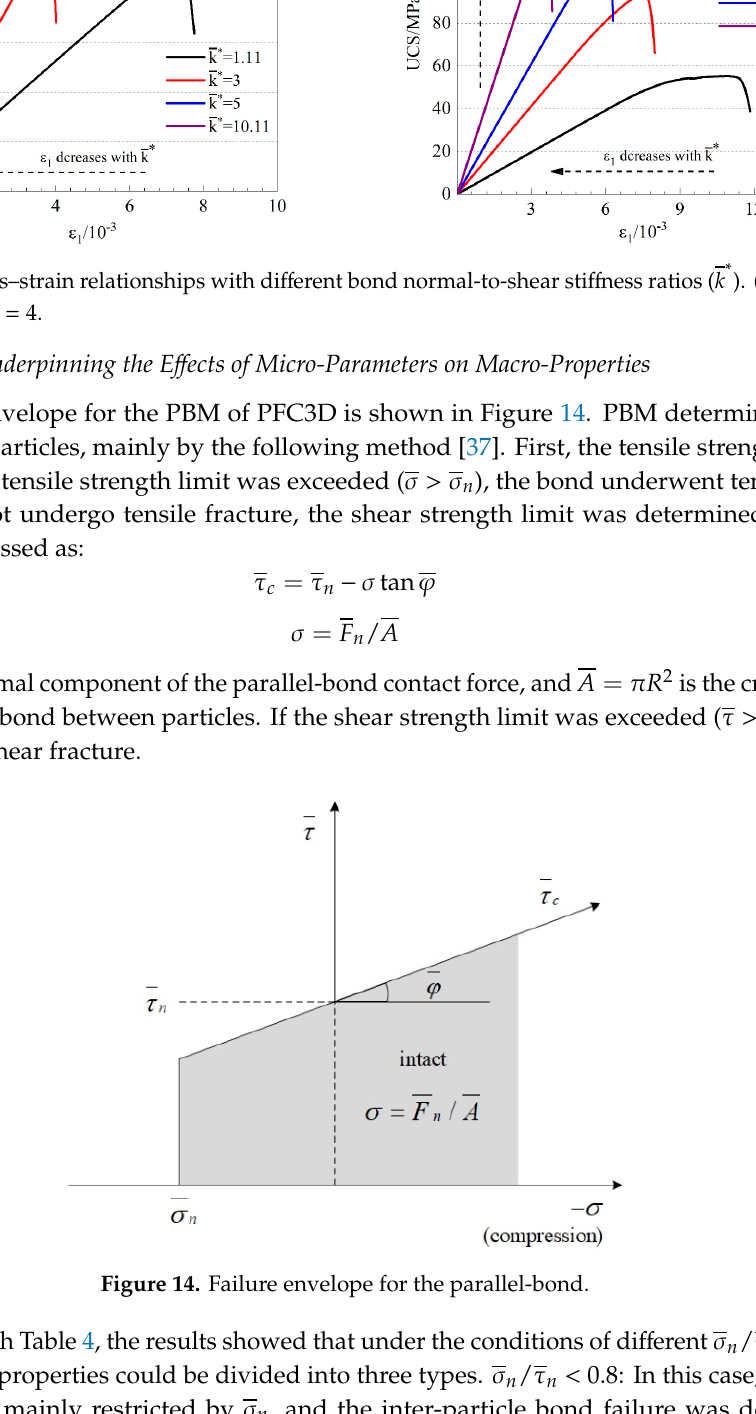
Figure 14. Failure envelope for the parallel-bond.